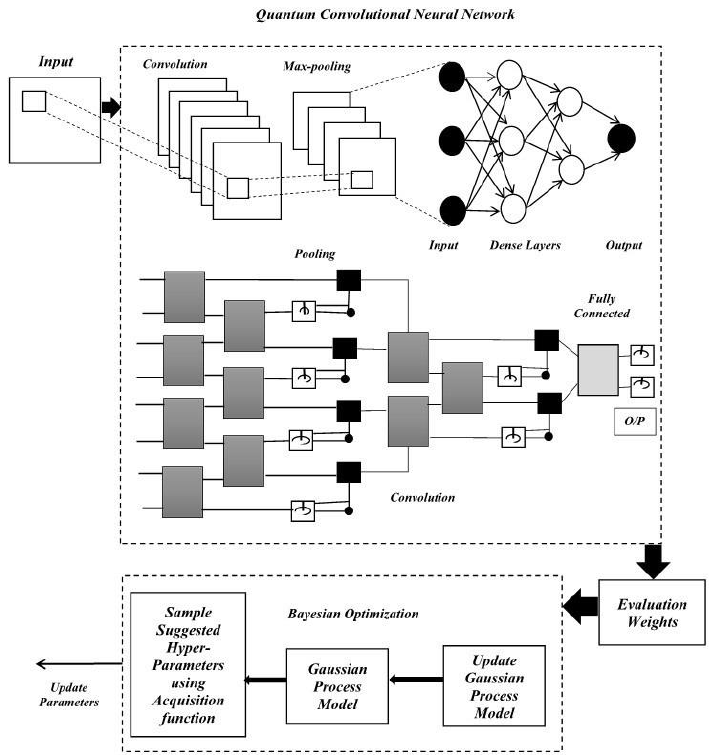
Figure 4. Architecture of the proposed